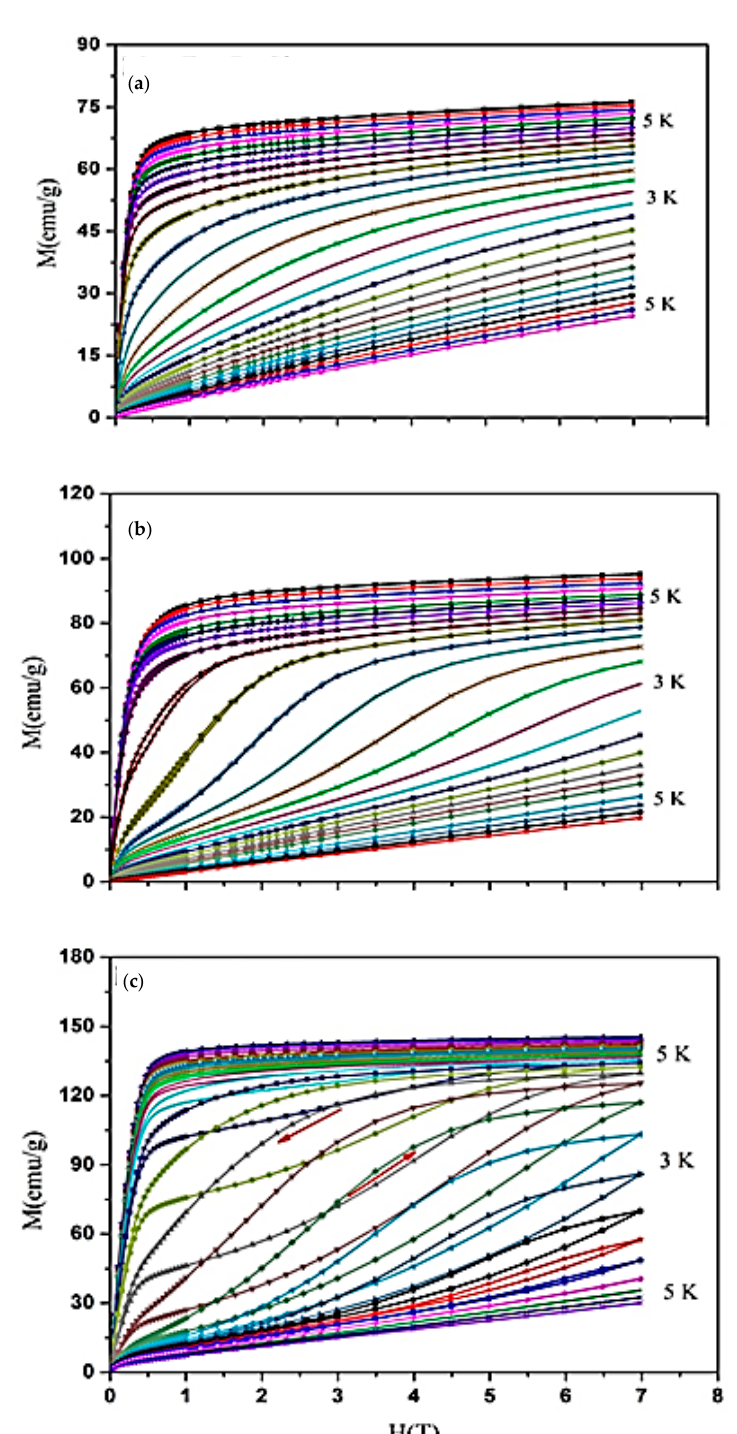
Figure 7. Magnetic isotherms: for ( a ) Mn 1.4 Fe 0.6 P 0.3 Si 0.7 , ( b ) Mn 1.3 Fe 0.7 P 0.35 Si 0.65 , ( c ) Mn 0.7 Fe 1.3 P 0.65 Si 0.35 .